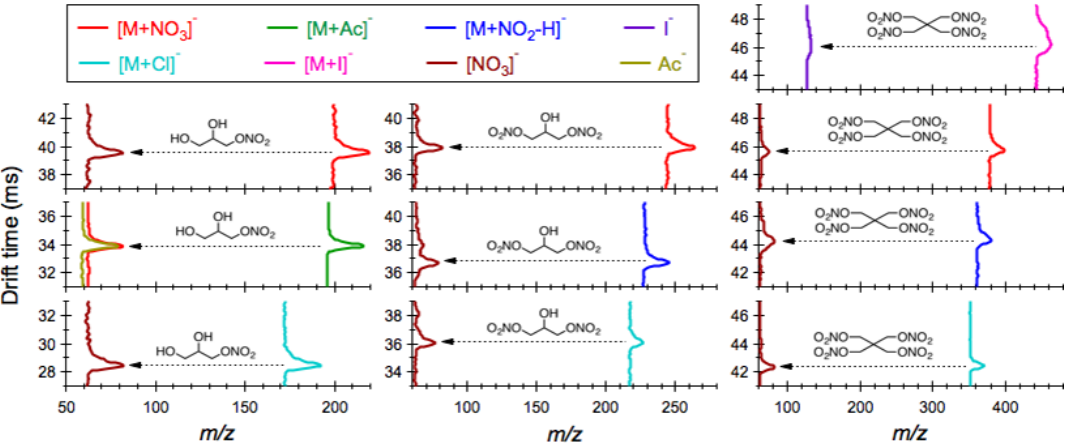
Figure 4. Characteristic fragment ions produced from MNG, DNG and PETN by clustering with acetate (Ac − ), chloride (Cl − ), iodide (I − ), nitrate (NO − ) and nitrite (NO − ) upon collision-induced dissociation performed at a CID voltage of 20V. 3 2